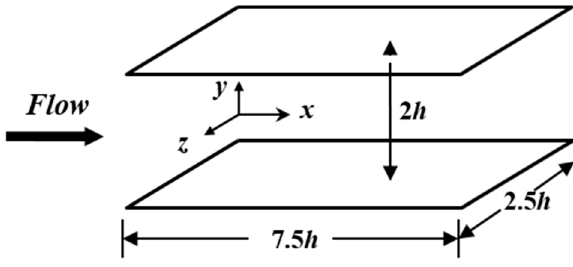
Figure 1. Computational domain.